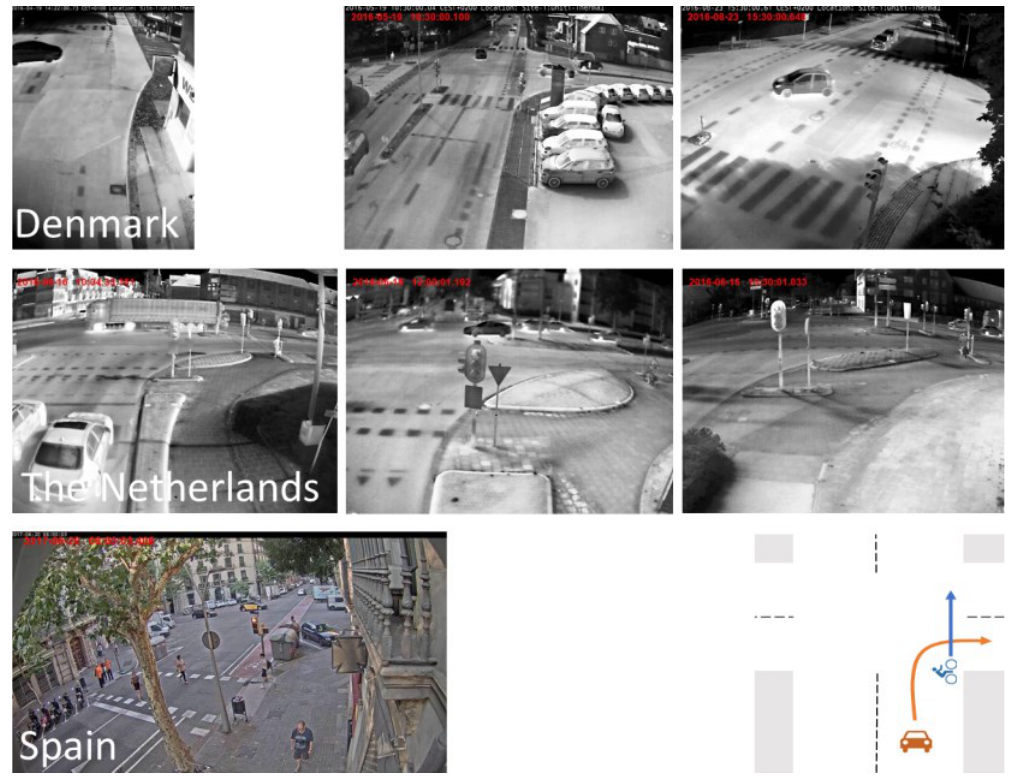
Figure 7 The camera view at the seven intersections and the studied interaction; thermal camera was used in Denmark and the